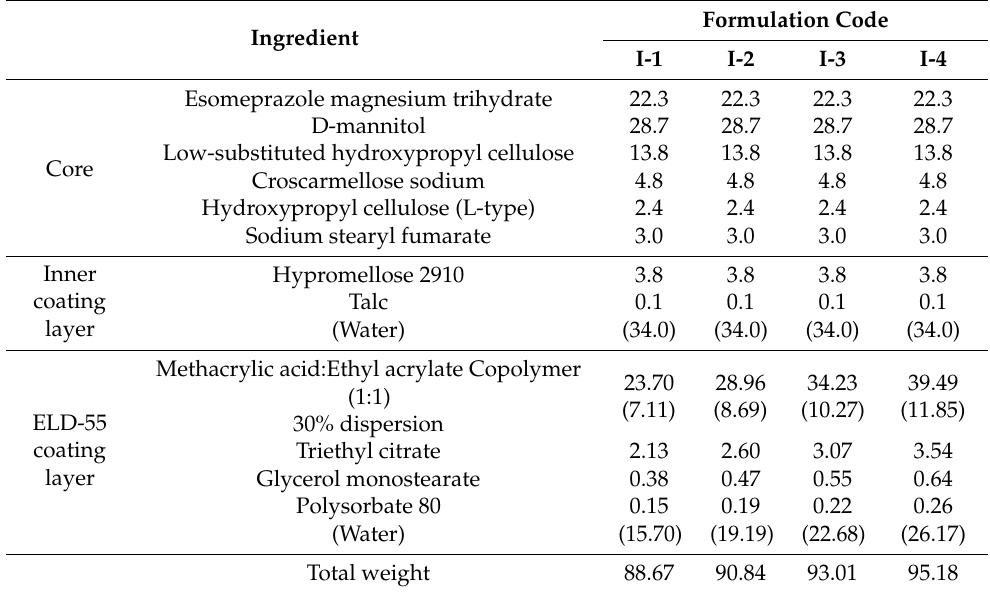
Table 2. Composition of EMP-loaded ELD-55-coated mini-tablet as 1st release mini-tablet. (Amount per capsule containing 10 mini-tablets, unit: mg).